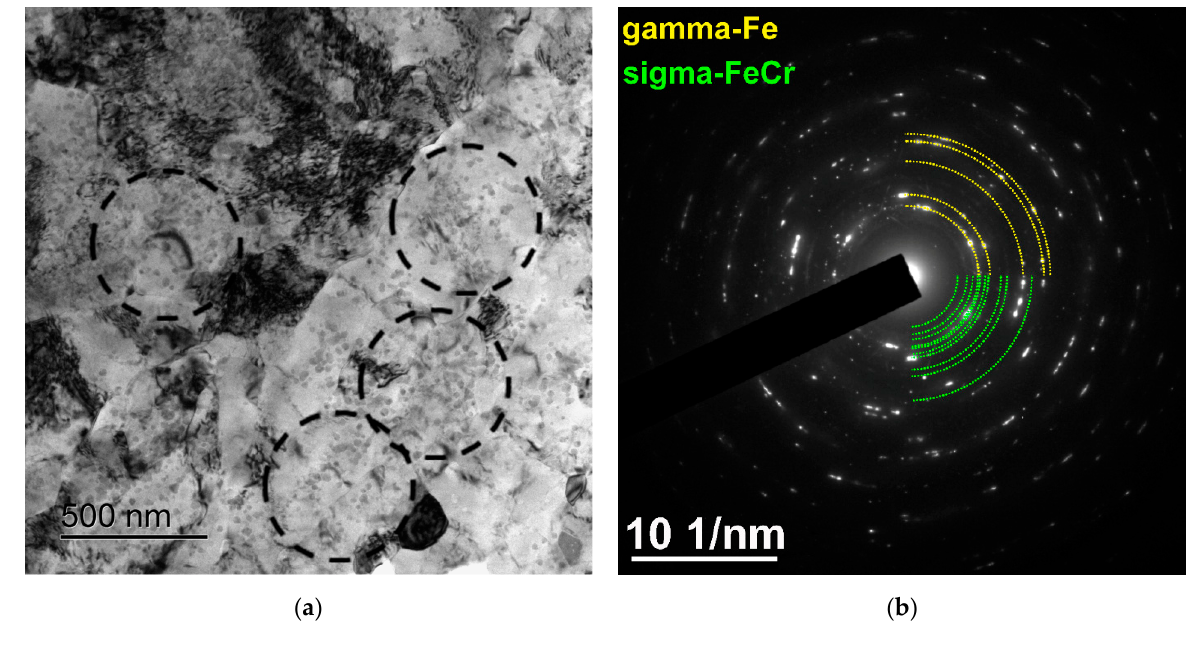
Figure 7. Nucleation of σ -phase particles in UFG steels (N = 4, Т ECAP = 450 °C) after heating to 800 ° С and holding for 60 min. TEM-microphotographs ( a ) and electron diffraction patterns ( b ). Intensive particle nucleation regions are marked with dash lines.